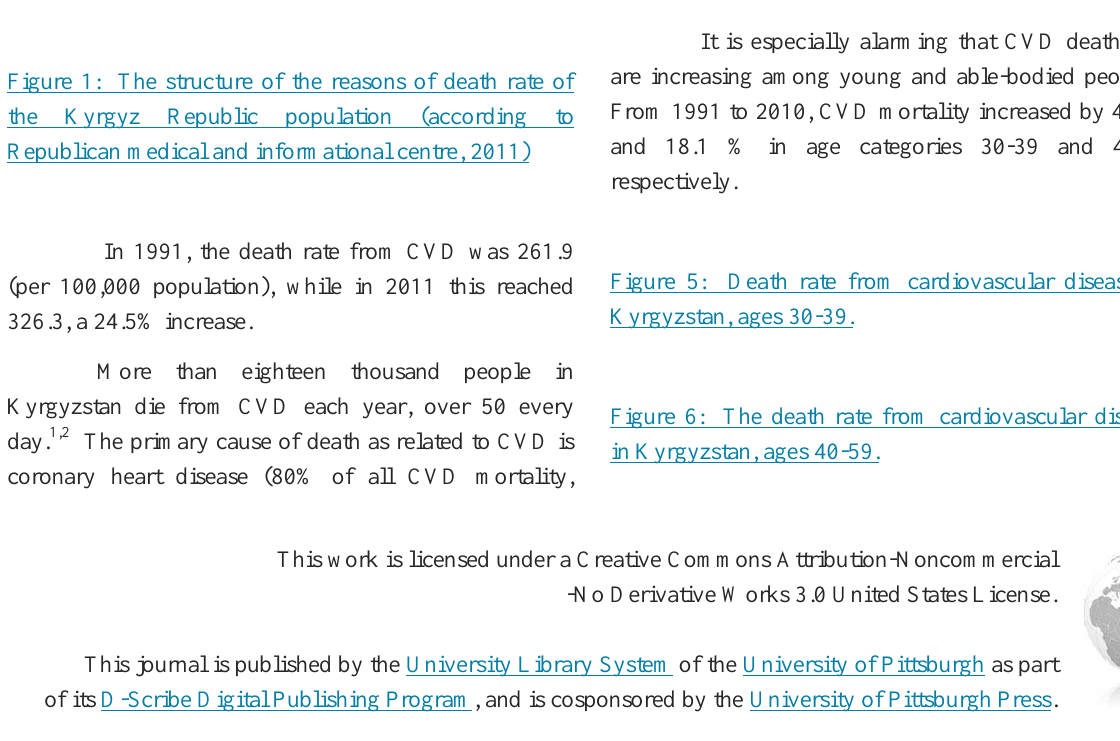
Figure 4: Standardized death rate from coronary heart diseases (per 100,000 population, WHO, 2004)